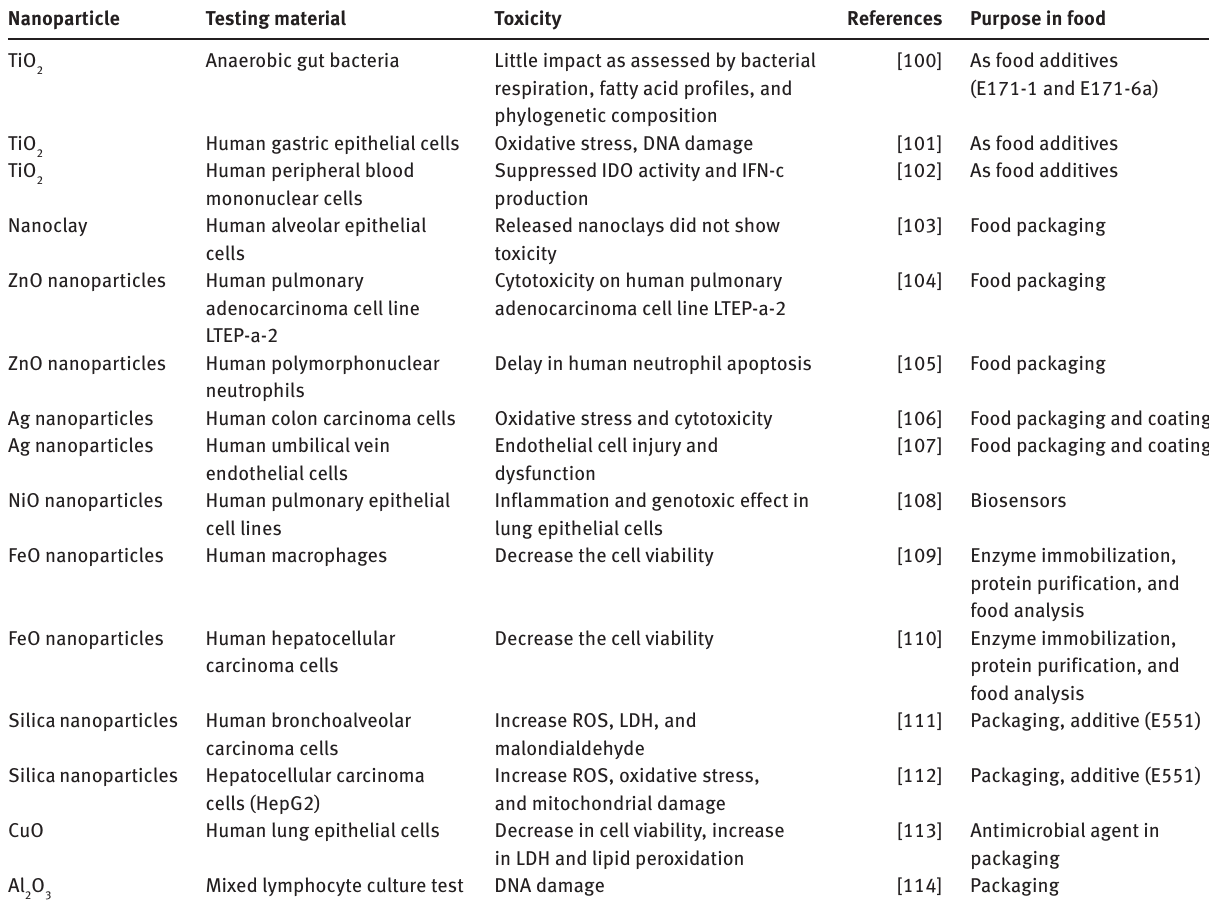
Table 1: Uses and toxicity of nanoparticles used in different food.